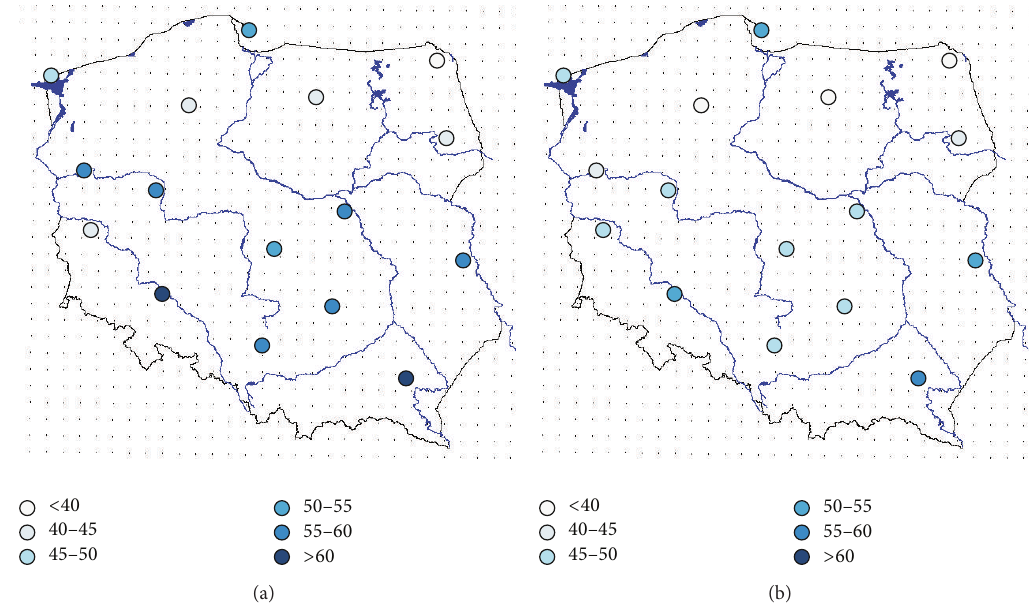
Figure 7: The increases of the annual evaporation from the water bodies [in mm] in the future (2061–2090) compared to the control period 1961–1990, based on MPI-M-REMO model (a) and average value from five models (b). Table 8: The increases of the annual evaporation [in mm] for different land-use units in the future (2061–2090) compared to the control period 1961–1990, based on the MPI-M-REMO model.